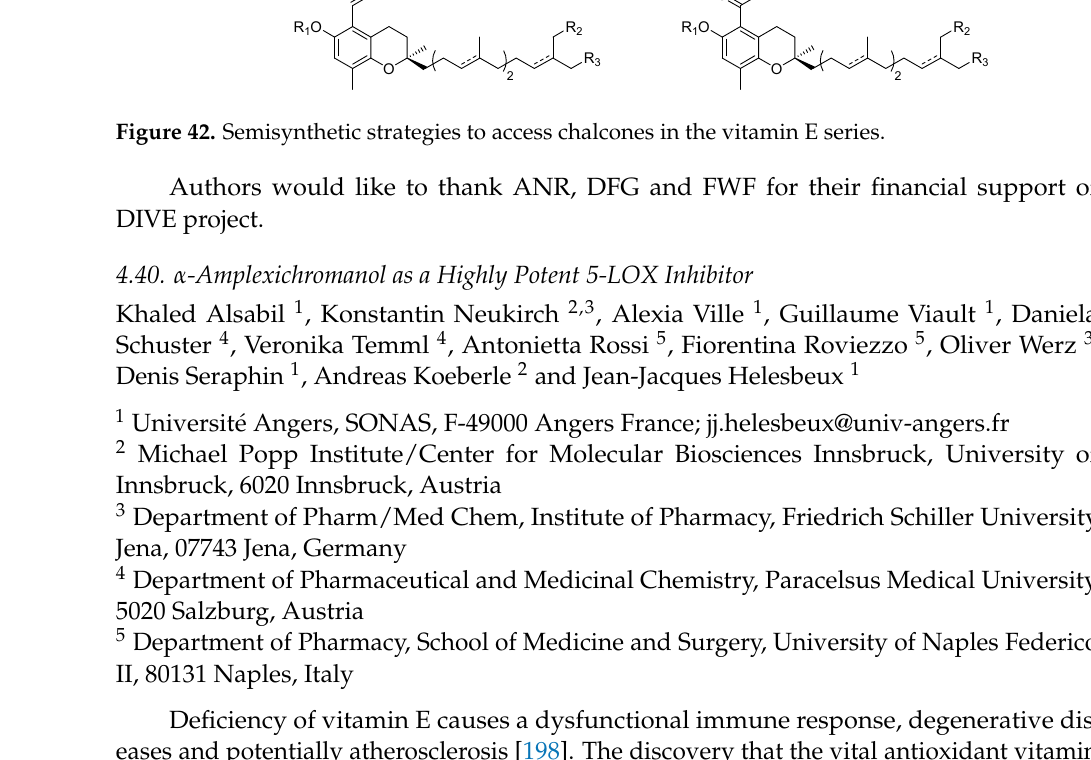
Figure 43. ( 1a ) From α -tocopherol to the corresponding ω -alcohol and ω -carboxylic acid. ( 1b ) α - amplexichromanol (structure and pose/interactions within the allosteric site of 5-LOX) .